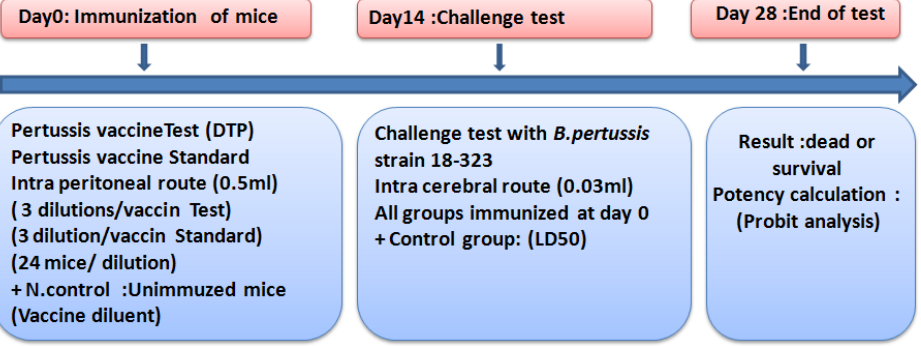
Figure 1. The mouse protection test steps (MPT) (Kendrick test): (1) Day 0: immunization of one group of 24 mice by one dilution, simultaneously with a whole-cell pertussis vaccine combined with diphtheria and tetanus antigens (DTP) and a standard pertussis vaccine (three dilutions/vaccine, 0.5 mL, intraperitoneally), Plus a negative control (N.control) of 10 non-immunized miceinjected with diluent vaccine. (2) Day 14: challenge test with a suspension of B. pertussis of all groups of mice (0.03 mL, Intracerebrally), plus a control group of non-immunized mice infected with B. pertussis (LD50 estimation). (3) Day 28: final reading and recording of surviving mice to estimate the potency relative to the pertussis vaccine tested (Probit analysis).